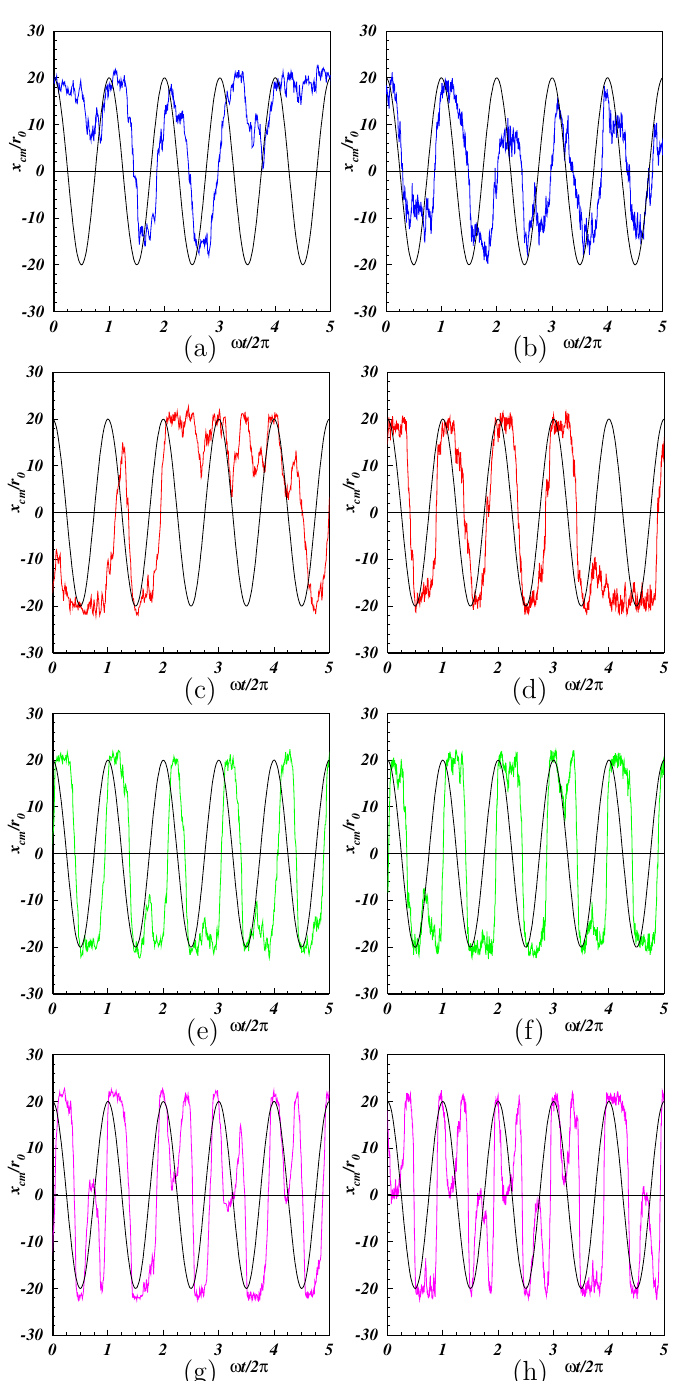
Figure 3. Time-dependence of the center-of-mass coordinate along the x -axis for L p / L = 0.5 ( left ) and 2 ( right ), and Wi = 10, 25, 50, 100 ( from top to bottom ). The black lines correspond to the externally applied shear flow with arbitrary